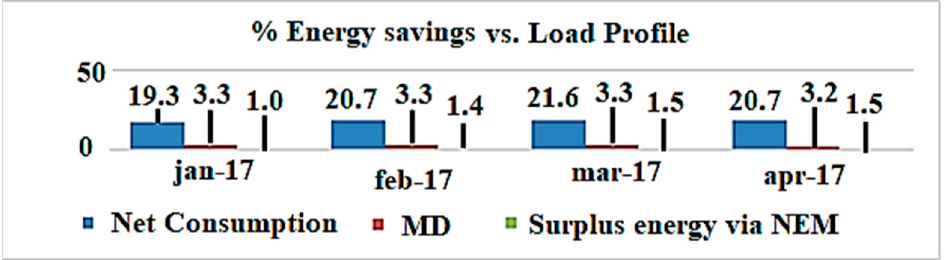
Figure 8. Percentage of energy savings based on load profile.